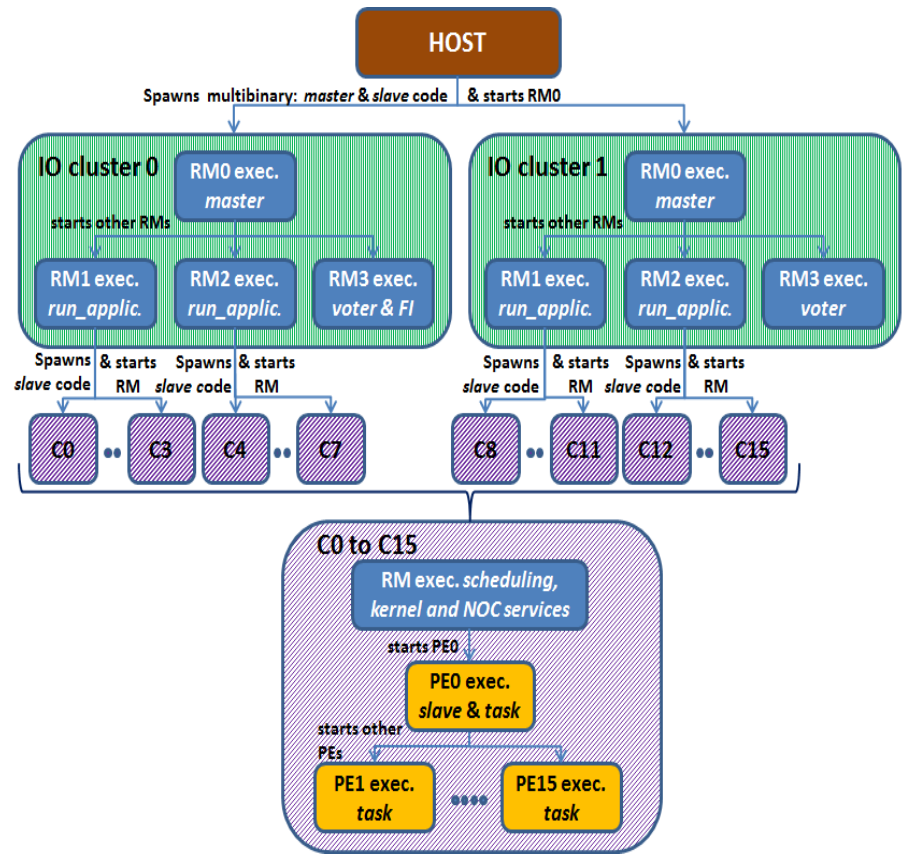
Figure A4. Booting process of the 4MR-8Par